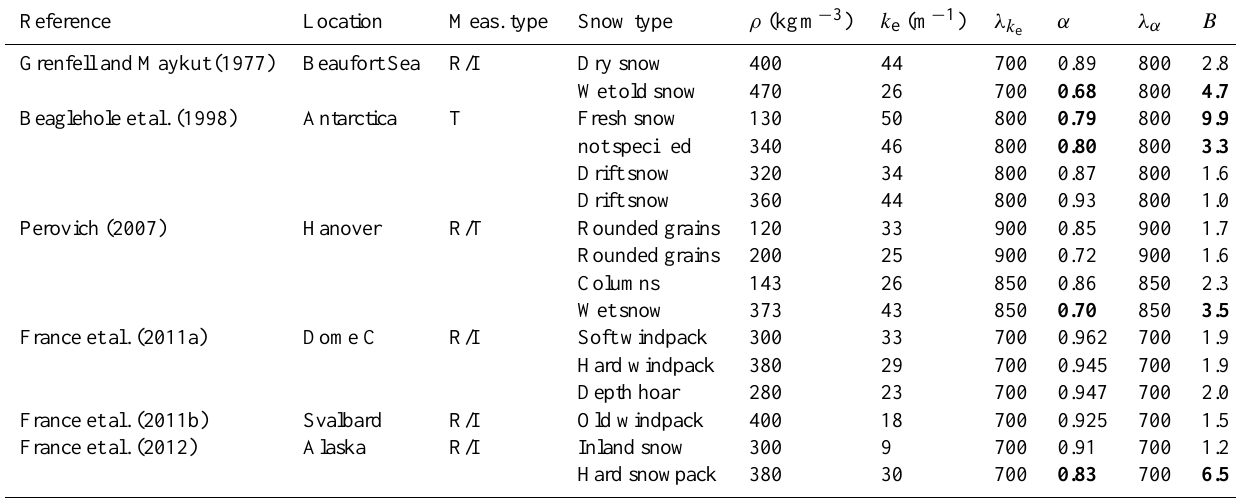
Table 3. Determination of B from data in the literature, using Eq. (12). λ k and irradiance, respectively, and refer to the measurements performed in the corresponding study. The five values of B larger than 3 . 16 and the corresponding α values are bold. These values are